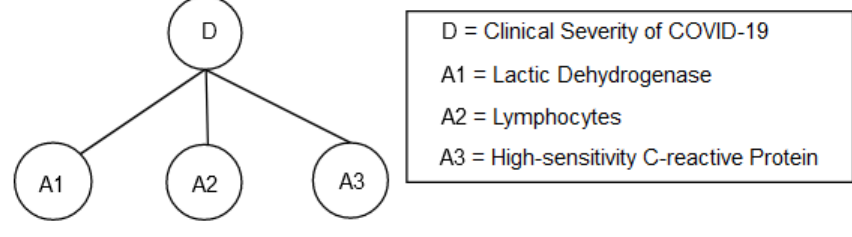
Figure 3. BRB model for clinical severity of COVID-19. Table 4. The referential points and corresponding numerical values of antecedent lactic dehydrogenase (LDH).